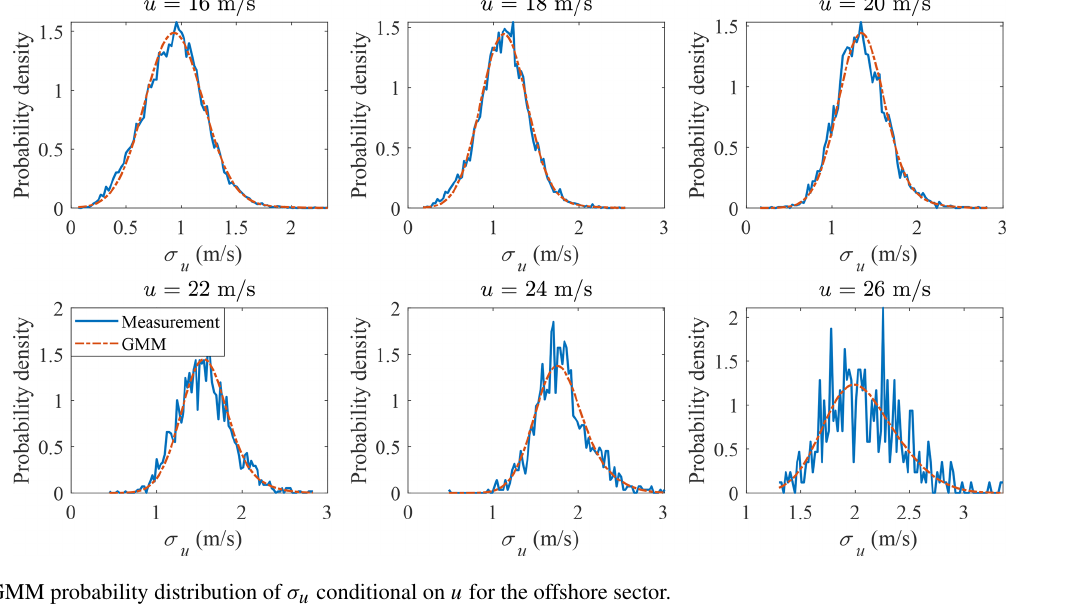
Figure 12. GMM probability distribution of σ u conditional on u for the offshore sector.